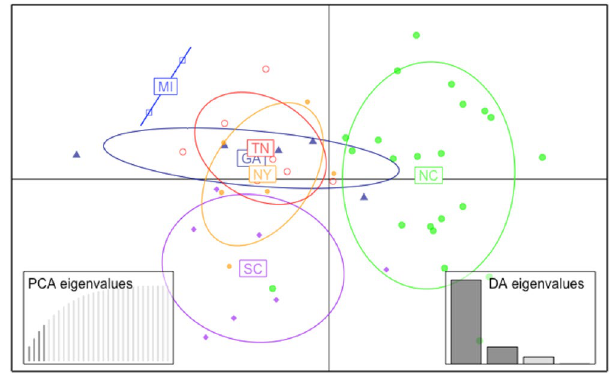
Figure 3. DAPC scatterplot of 50 P . capsici isolates sampled from 6 different states. Points represent individual isolates and different colors represent different states.